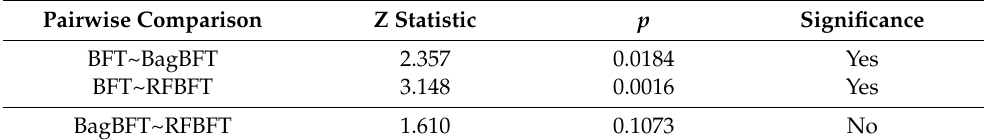
Table 6. Wilcoxon signed-rank test of the models with the training dataset. Pairwise Comparison Z Statistic p